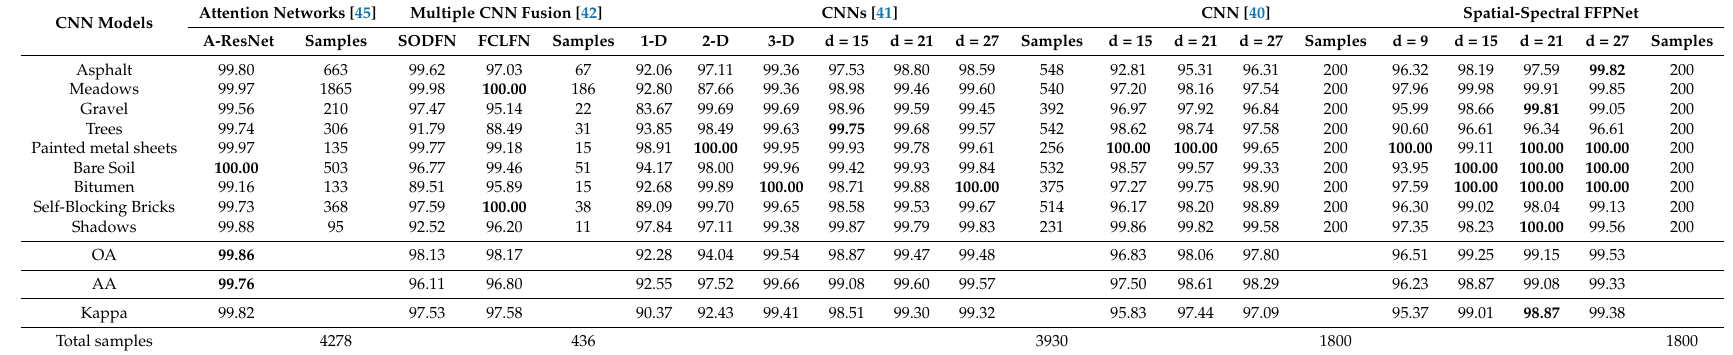
Table 18. Classification accuracies (in %) of different CNN models developed from 2016 to 2019 and the proposed model for the UP dataset (with maximum epoch = 200, mini-batch size = 24). The values in bold are the best. The CNN by [40] is considered the